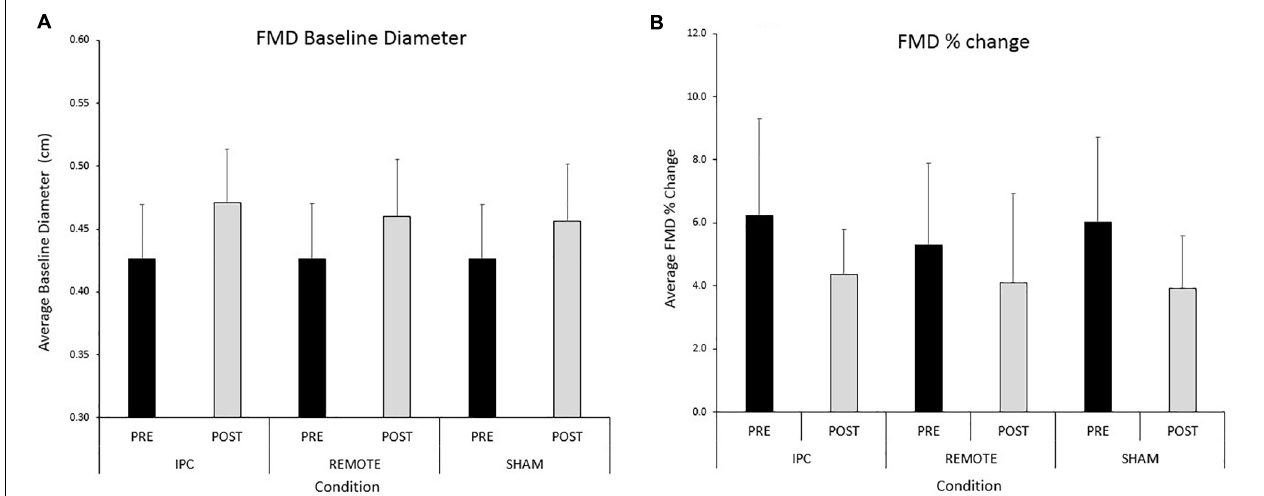
FIGURE 3 | Mean ± SD: data reported for (A) baseline diameter and (B) FMD pre- and post-exercise for each condition. TABLE 2 | Pre- and post-exercise FMD responses (mean ± SD) for peak diameter (cm), time to peak dilation (s), and baseline shear rate (SR AUC ). Condition IPC REMOTE SHAM P -Value Time point Pre Post Pre Post Pre Post Condition Peak diameter response (cm) Time to peak (s)